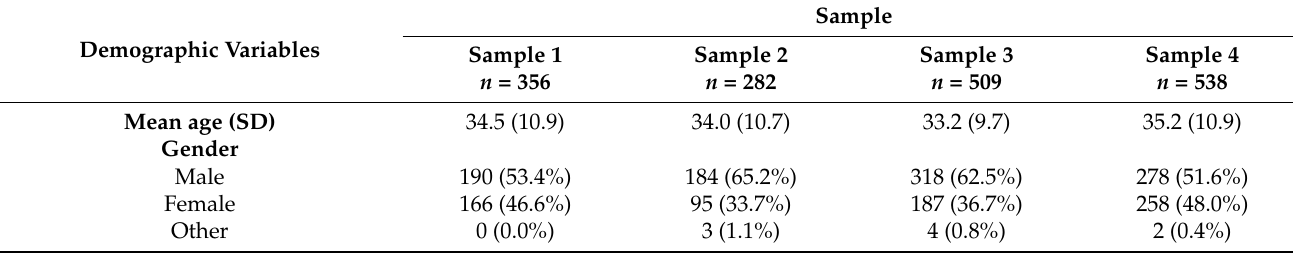
Table 1. Demographic characteristics of the four